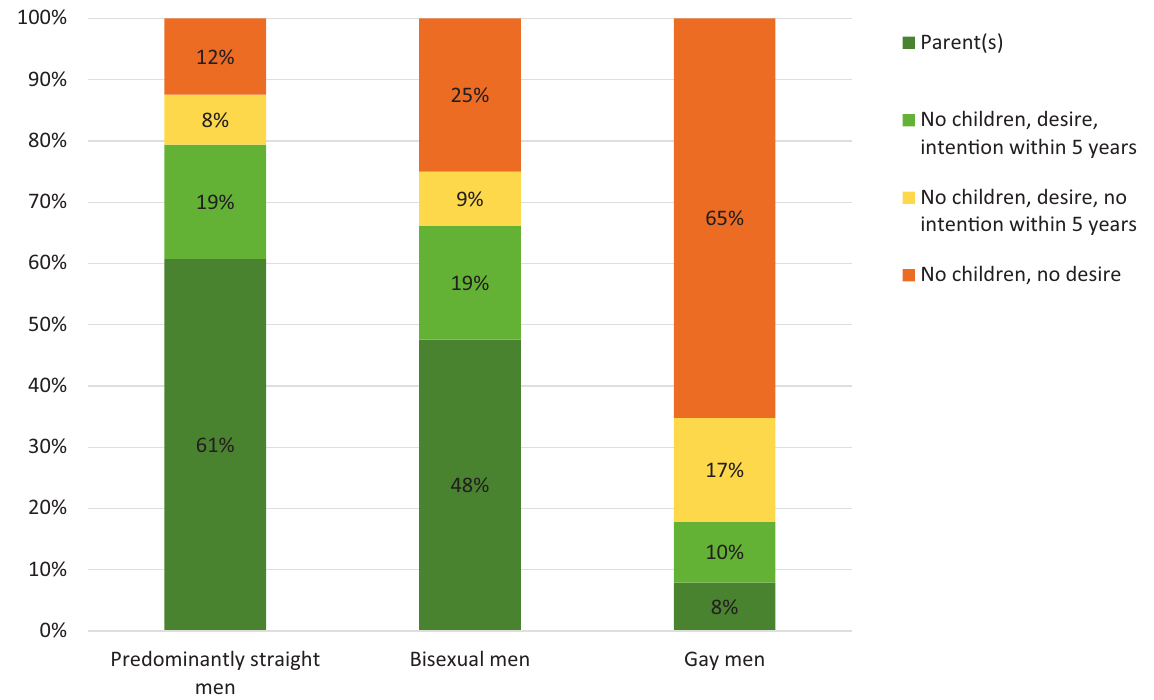
Figure 2. Parenthood, parenting desires and intentions, by men’s sexual identities. Note: Chi‐square test is statistically sig‐ nificant (Sig. =